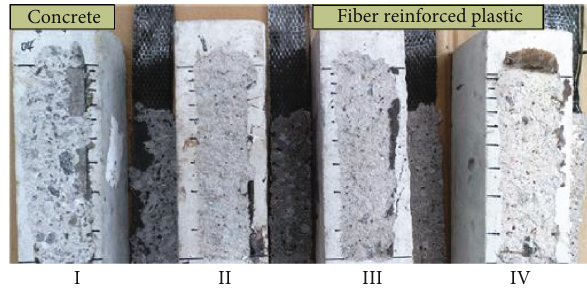
Figure 3: Interfacial debonding of single-lap shear test under di ff erent strain